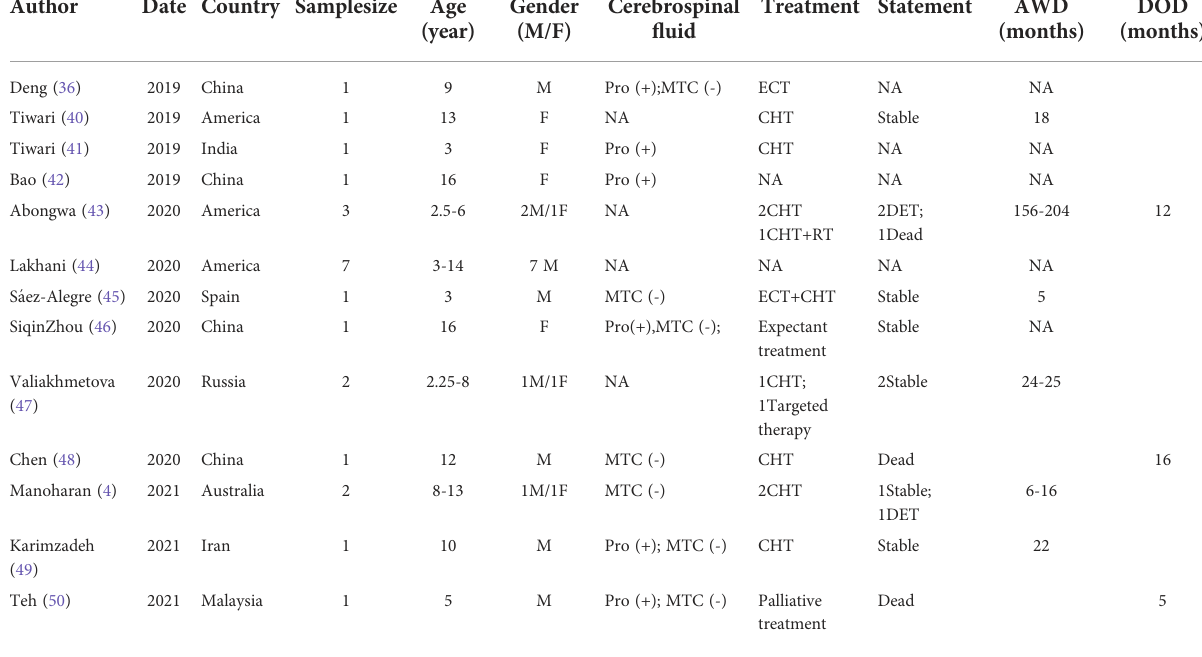
protein content and 1 case showed normal protein content without malignant tumor cells.